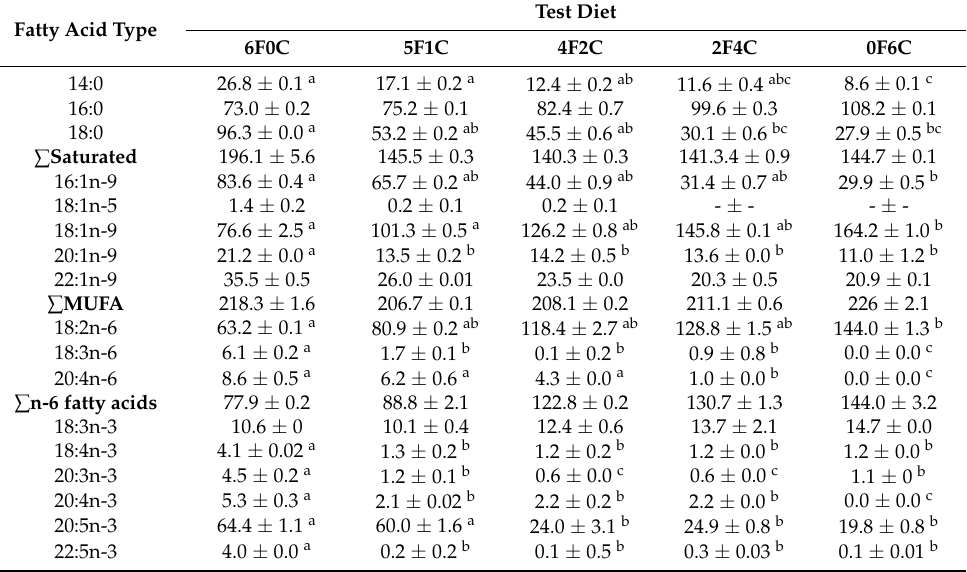
Table 6. Fatty acid composition (mg/g lipid) in the muscle of red seabream ( Pagrus major ) fed the experimental diets for